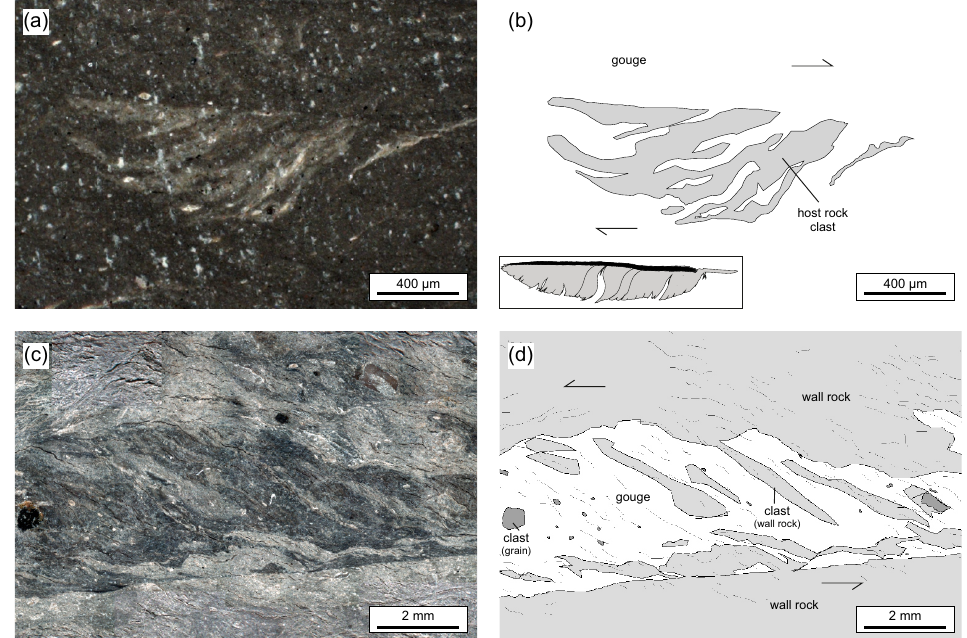
Figure 7. Host rock clasts in gouge type 1. (a) Reflected light micrograph and (b) sketches of sample A9c-1 polished using a large-area BIB. (c) Shaded light photograph of water-immersed sample V04 showing foliation. Note the sigmoidal S-C like pattern of the clasts, which suggests a progressive rework of the host rock into gouge. See text for details.